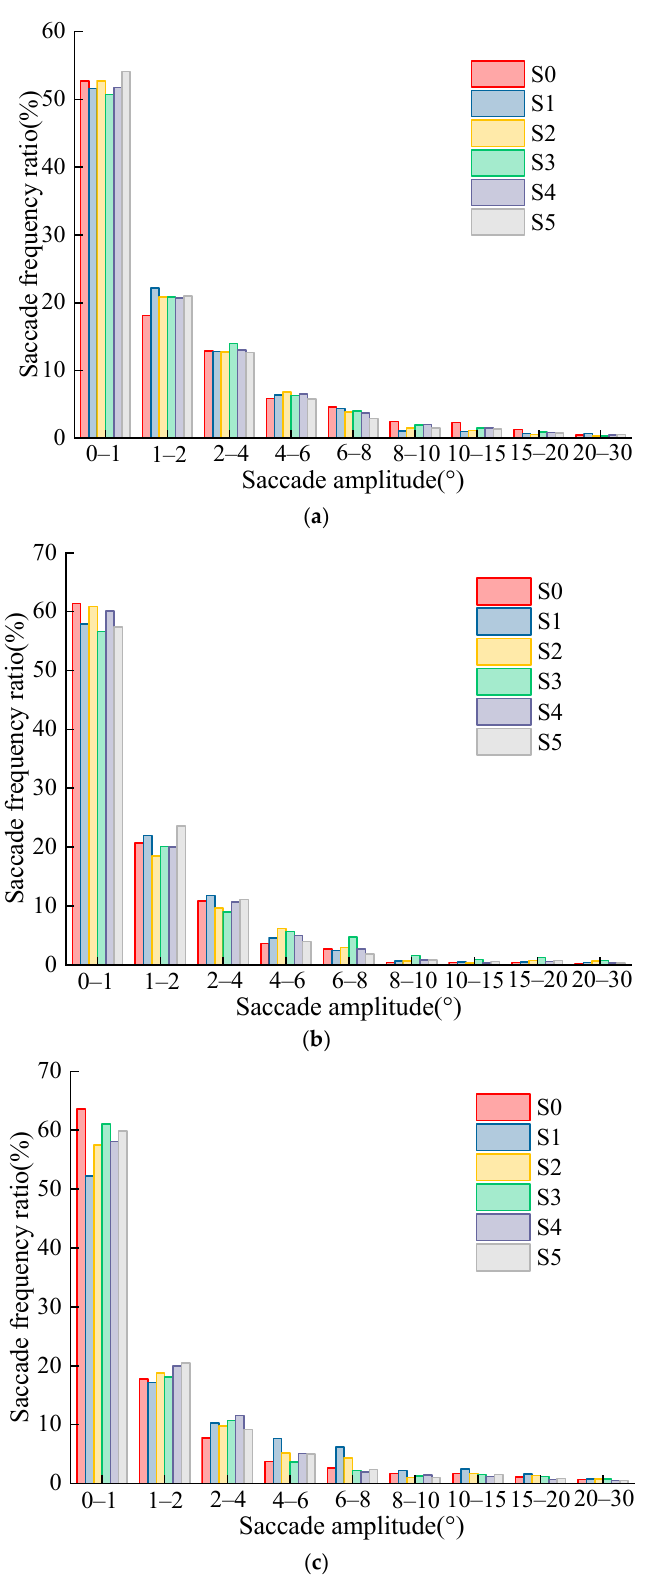
Figure 7. Distribution of driver’s saccade amplitude at different TSIV of the three-speed conditions. ( a ) 60 km/h; ( b ) 80 km/h; ( c ) 100 km/h. By analyzing the driver’s saccade amplitude at 60 km/h, 80 km/h, and 100 km/h, the following results can be identified.